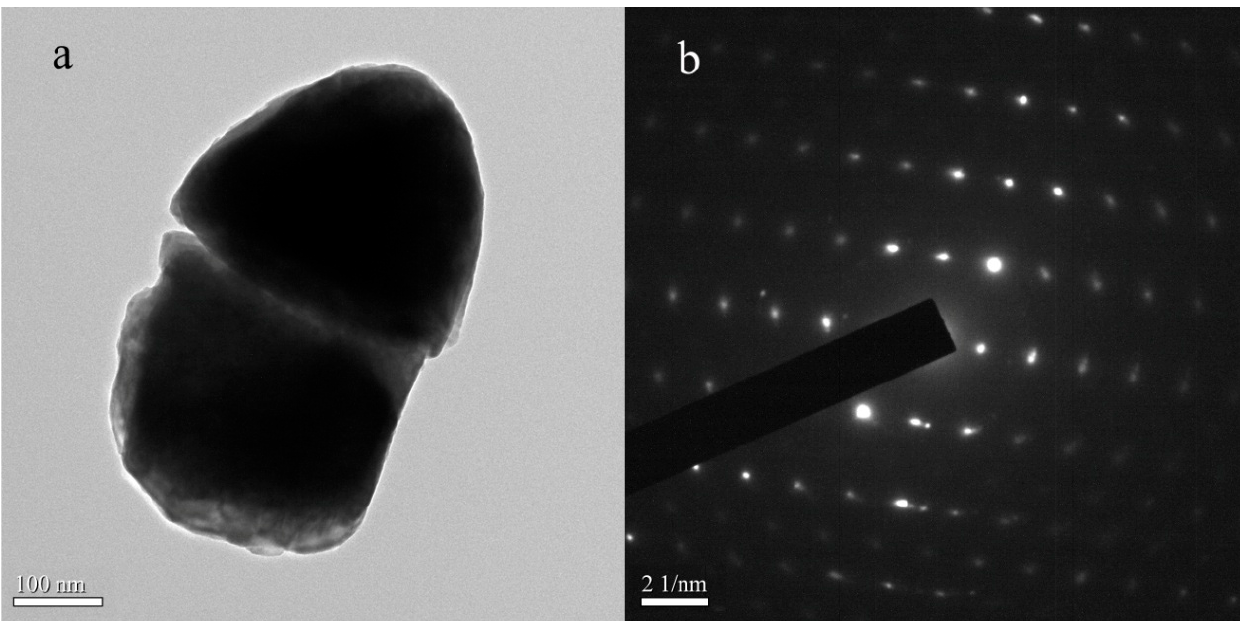
Catalysts 2023 , 13 , x FOR PEER REVIEW Figure 9. TEM image of In 2 CdO 4 ( a ) and a selected area’s electron di ff raction pa tt ern of In 2 CdO 4 ( b ). Figure 9. TEM image of In 2 CdO 4 ( a ) and a selected area’s electron diffraction pattern of In 2 CdO 4 ( b ).